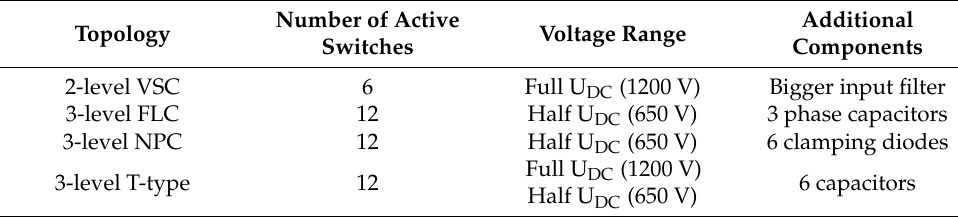
Figure 2. Block schemes of active AC/DC converter topologies: ( a ) 2-level Voltage Source Converter (VSC); ( b ) 3-level Floating Capacitor Converter (FLC); ( c ) 3-level T-type converter; ( d ) Neutral Point Clamped Converter (NPC). Table 1. Comparison of basic parameters of the analyzed AC/DC